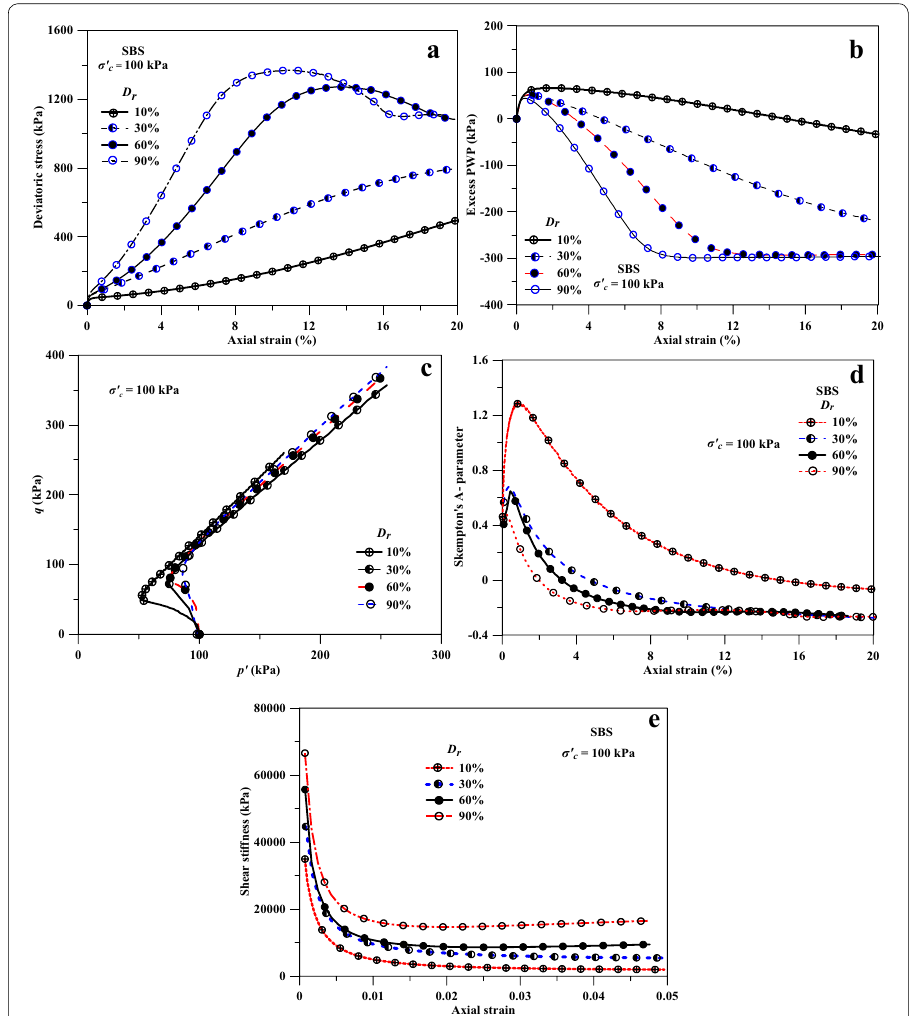
Fig. 7 Influence of D r on the response of SBS subjected to monotonic loading and σ ′ c strain response, b excess PWP, c stress path, d Skempton’s A-parameter, e shear stiffness, SBS at different D